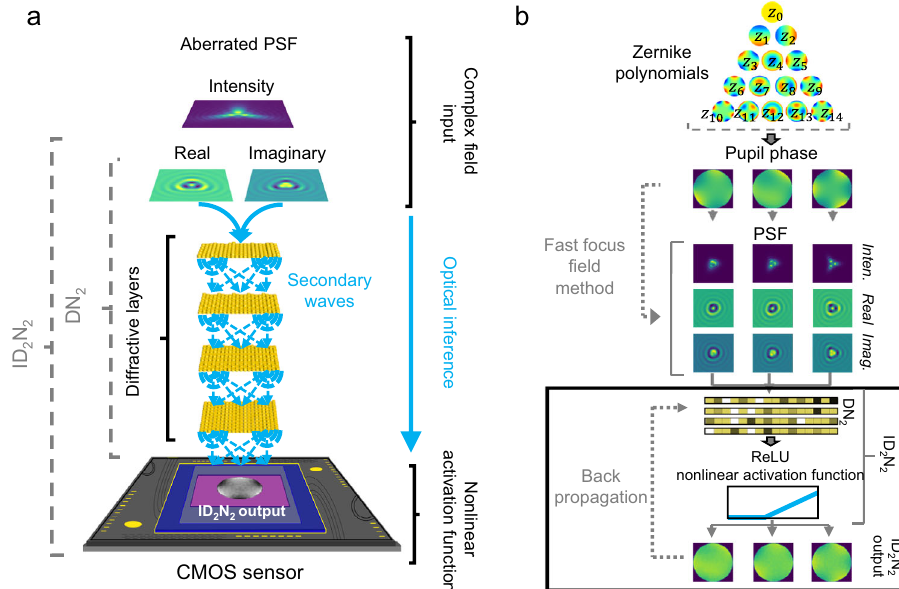
Fig. 1 | Integrated Diffractive Deep Neural Networks (ID 2 N 2 ). a Schematic of a diffractive neural network integrated on a commercial CMOS chip performing pupil phase retrieval. An ID 2 N 2 comprises a diffractive neural network (DN 2 ) and an activation function based on the nonlinear response of the CMOS detector module. The DN 2 consists of multiple diffractive layers, where each point on a given layer acts as a diffractive neuron, with a complex-valued transmissioncoef fi cientthatcanbetrainedbyusingdeeplearningtoperforma function between the input and output planes of the network. b Flow diagram